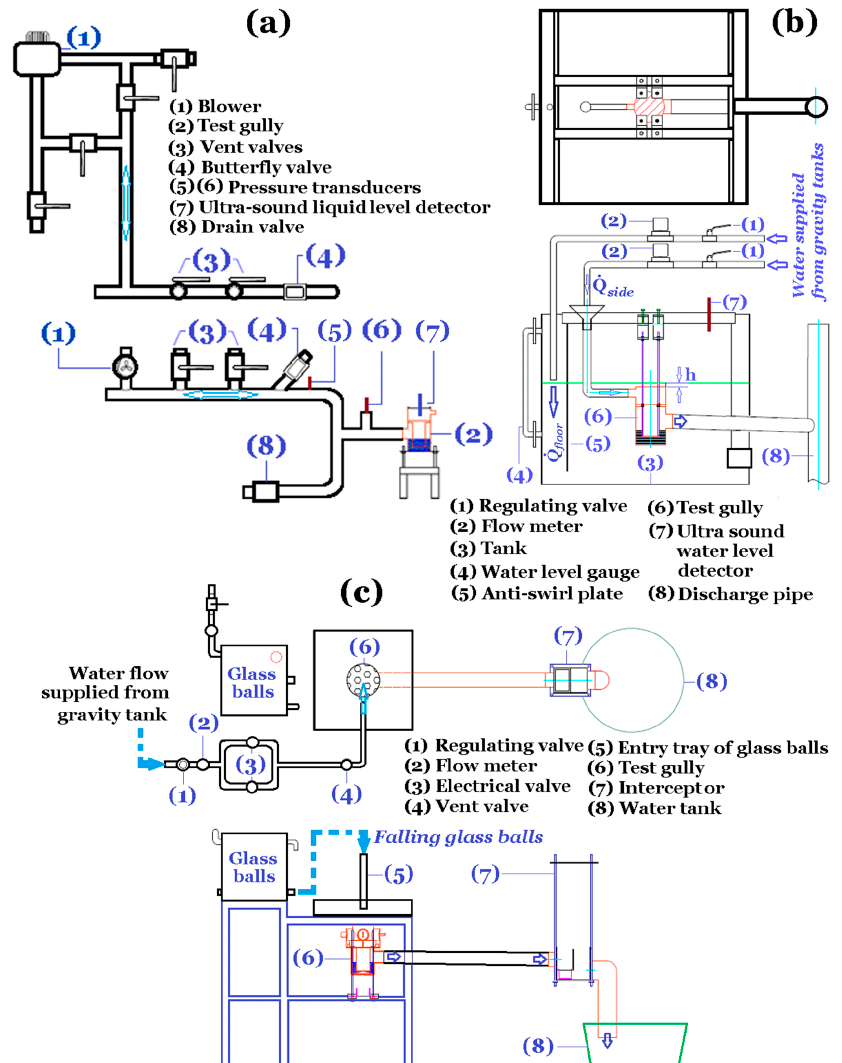
Figure 2. Experimental facilities for testing: ( a ) sustainable positive and negative pressures at steady and unsteady conditions; ( b ) maximum flow rate; and ( c ) self-purification performance.